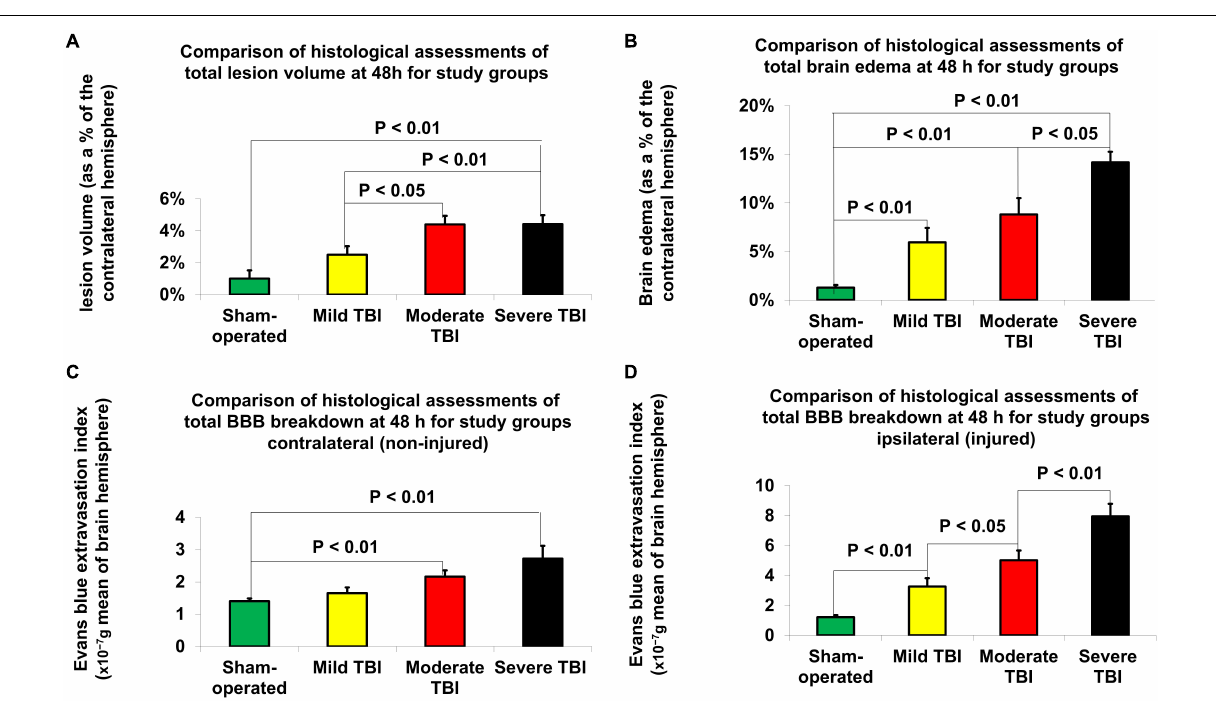
FIGURE 3 | Histological assessment of outcome parameters 48 h after TBI. (A) Lesion volume. The data are expressed as a percentage of the contralateral hemisphere and presented as mean ± SEM. (B) Brain edema. The data are expressed as a percentage of the contralateral hemisphere and presented as mean ± SEM. (C) Blood-brain barrier (BBB) breakdown on contralateral (non-injured) hemisphere. The data are measured in 10 - 7 g of brain tissue and presented as mean ± SEM. (D) BBB breakdown on ipsilateral (injured) hemisphere. Significant differences were found between groups of varying injury severity. The data are measured in ng/g of brain tissue and presented as mean ±